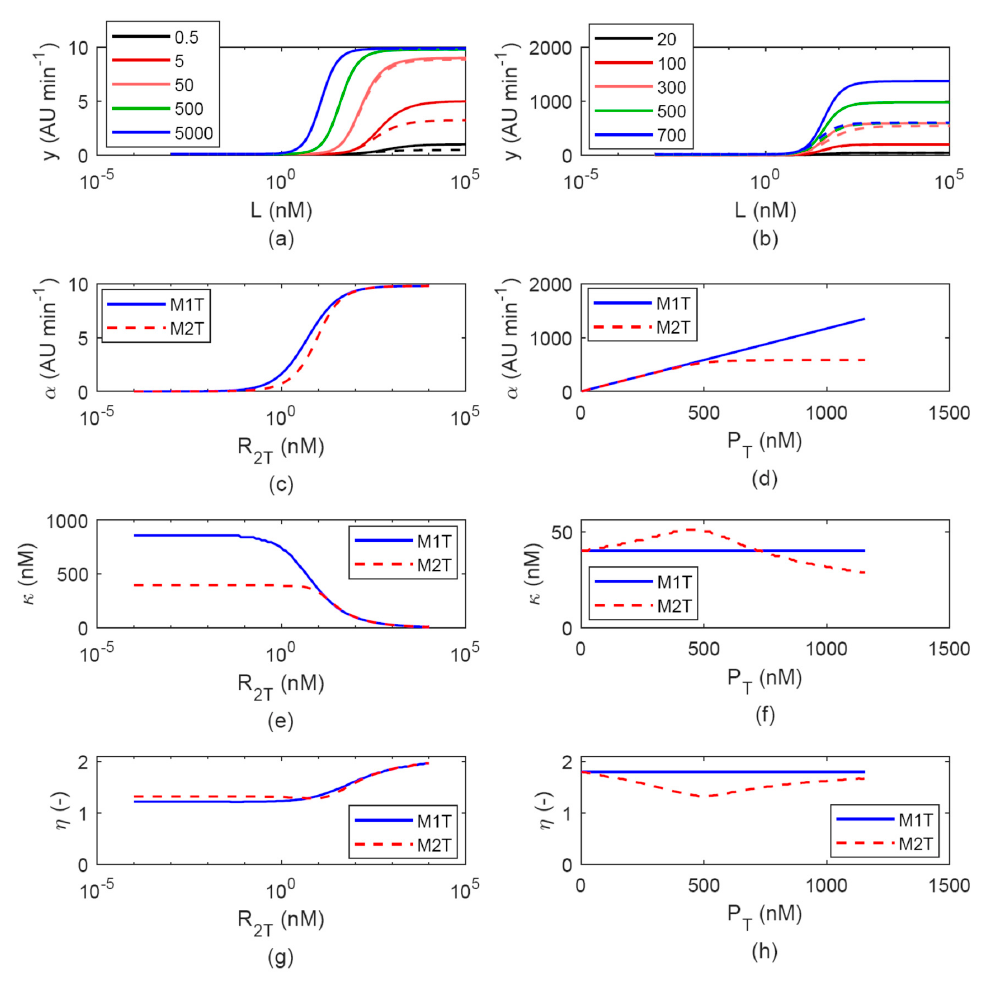
Figure 4. Comparison between M1T and M2T. Panels ( a ) and ( b ) report the output activation curves of M1T (solid lines) and M2T (dashed lines) for different values of R 2T (panel (a), as indicated in the legend, expressed as nM) and P T (panel (b), as indicated in the legend, expressed as per cell copy number). The ( c ) ‒ ( d ), ( e ) ‒ ( f ), and ( g ) ‒ ( h ) panel pairs report the R 2T - and P T -dependent trend of α , κ and η , respectively, with solid and dashed lines representing M1T and M2T, respectively. In panels (a),(c),(e),(g) the promoter copy number value was set to 5, while in panels (b),(d),(f),(h) the LuxR concentration was set to 500 nM.